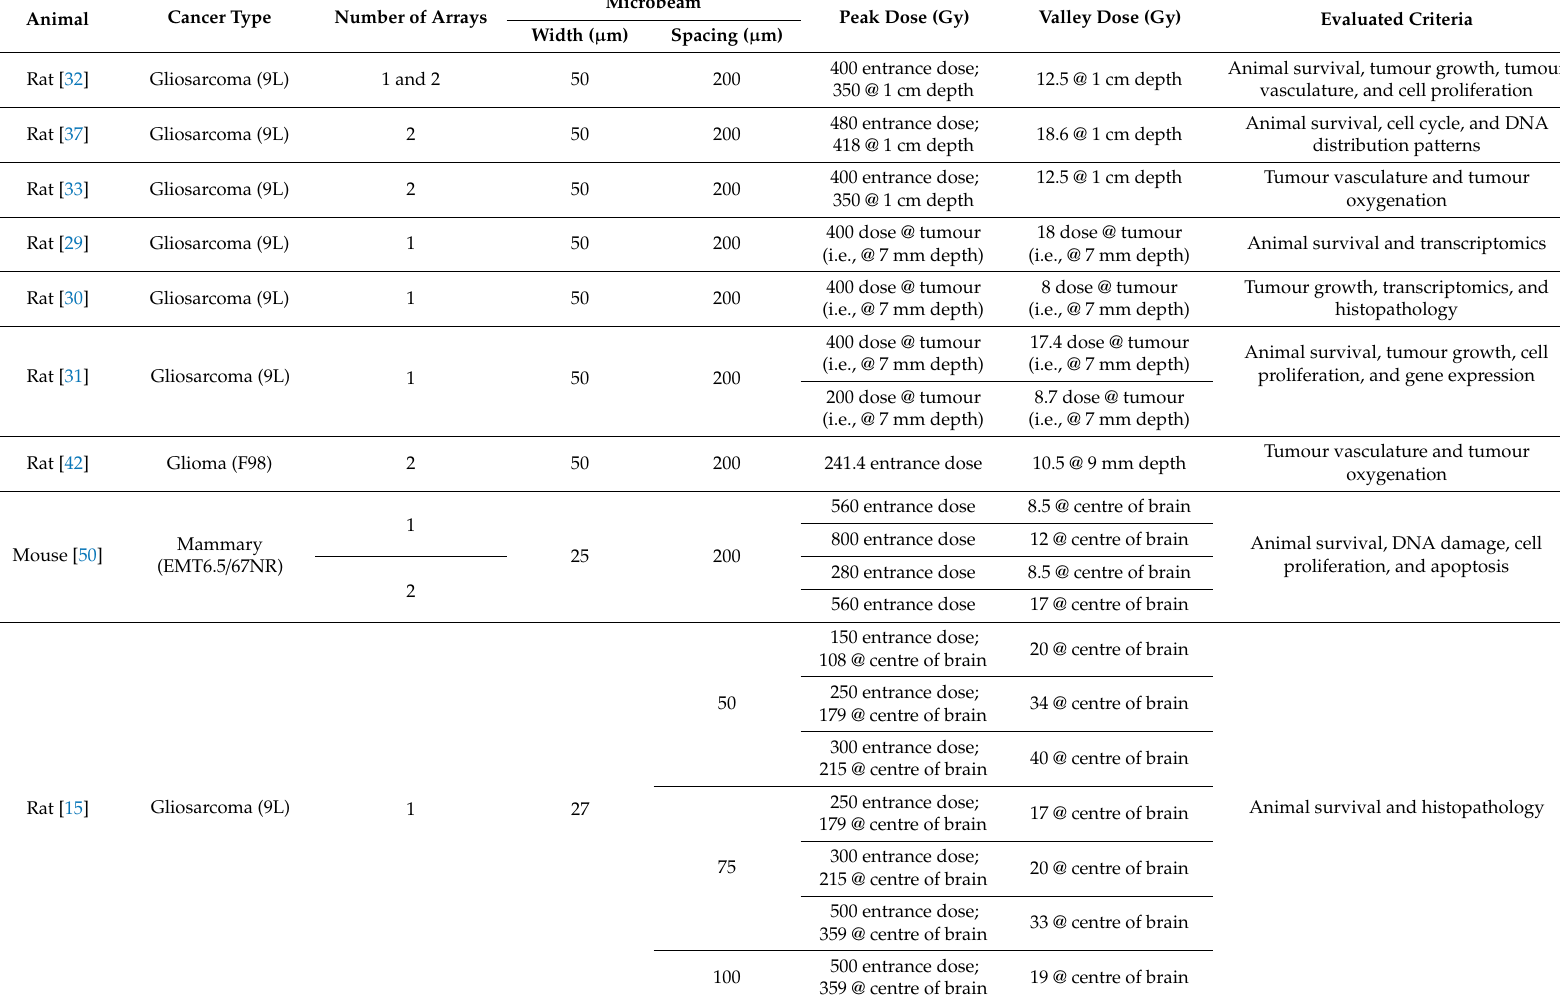
Table 1. MRT parameters used in cancer